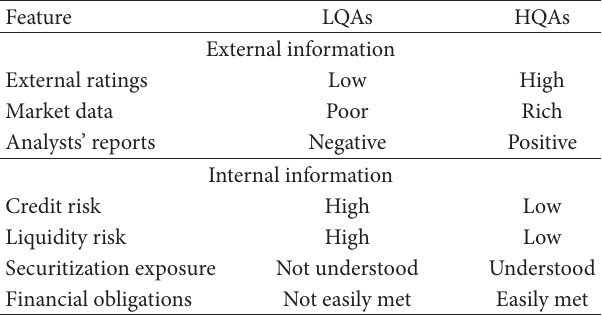
Table 1: Defining features of LQAs and HQAs; source: